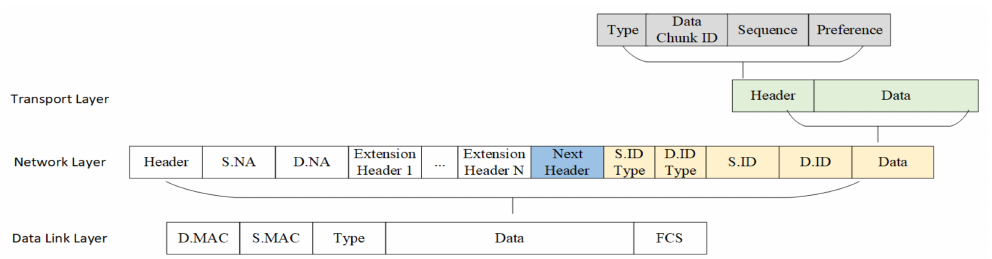
Figure 2. IDP protocol layer layout.